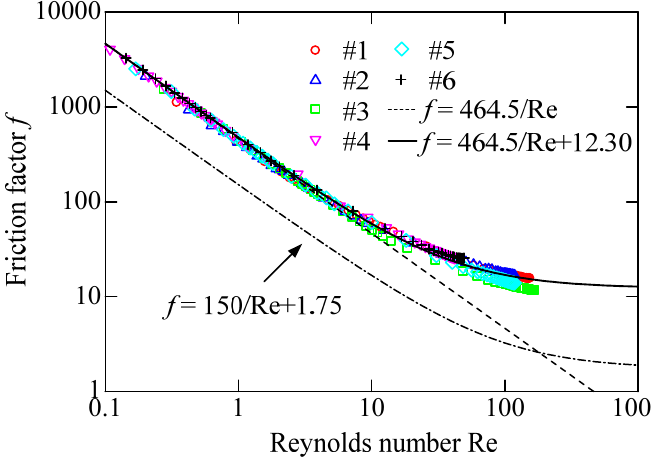
Figure 6. Relation between friction factor and Reynolds